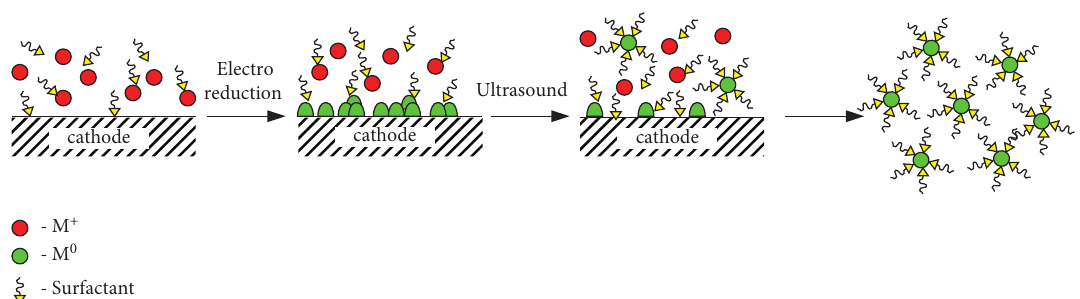
Figure 5: Scheme of MNPs formation by pulsed current supply and pulsed ultrasound in solution with